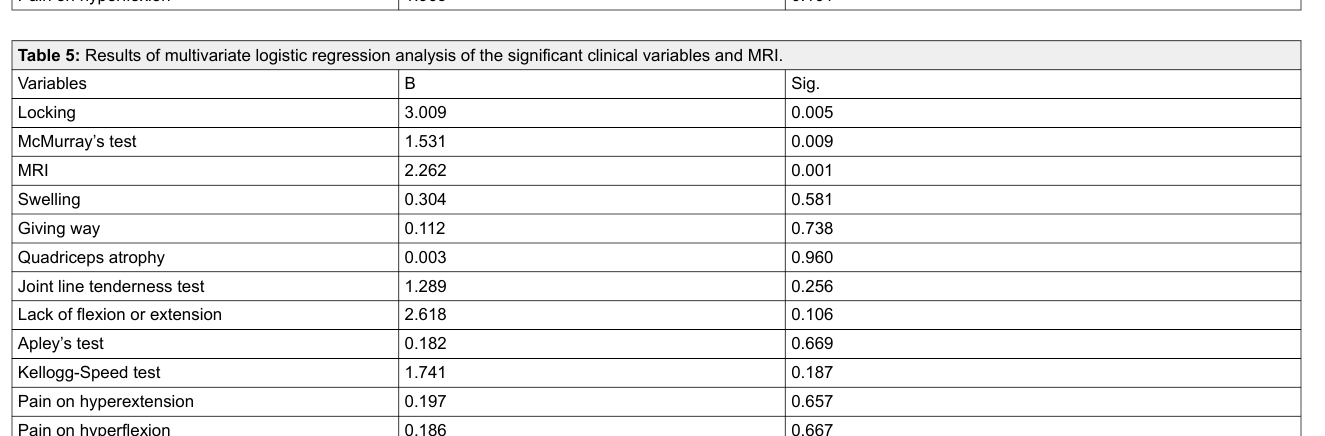
Table 5: Results of multivariate logistic regression analysis of the significant clinical variables and